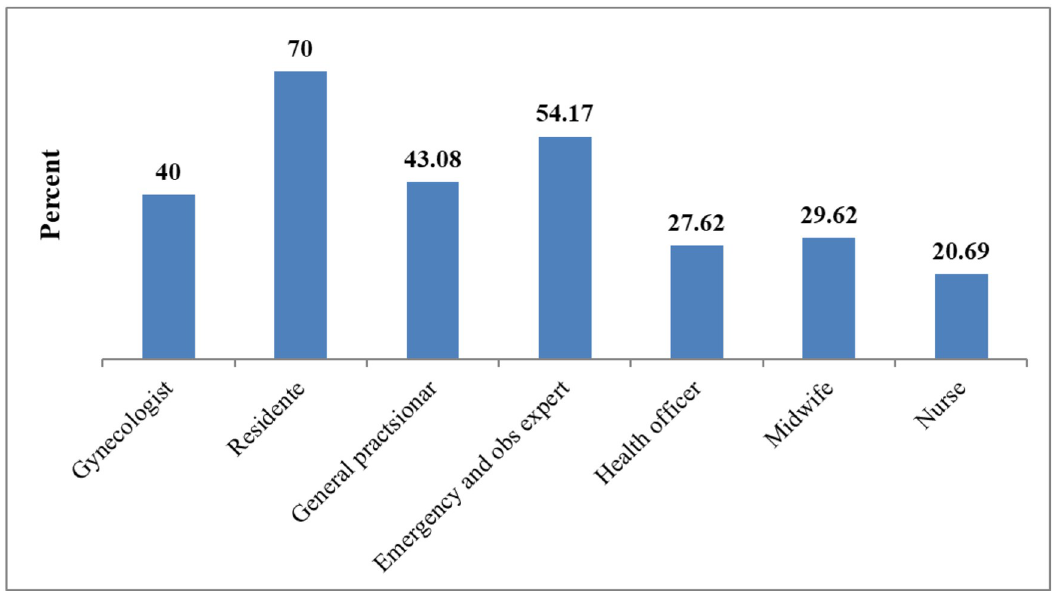
Fig 1. The proportion of good knowledge (50% and above) by profession in PPIUCD in Amhara regional state health facility, Ethiopia, (2016). https://doi.org/10.1371/journal.pone.0214334.g001 Female sex decreases the mean knowledge score on PP-IUCD by 0.4 points ( β = -0.41; -0.72, -0.10); The mean score of PP-IUCD knowledge were reduced by 0.9 in general practi- tioners, 1.3 in health officer, 1 in midwives, and 0.5 in nurses, compared with other health workers (obstetrician and gynecologists, and ESO), ( β = -0.88; 95%CI: -1.67, -0.83), ( β = -1.32;